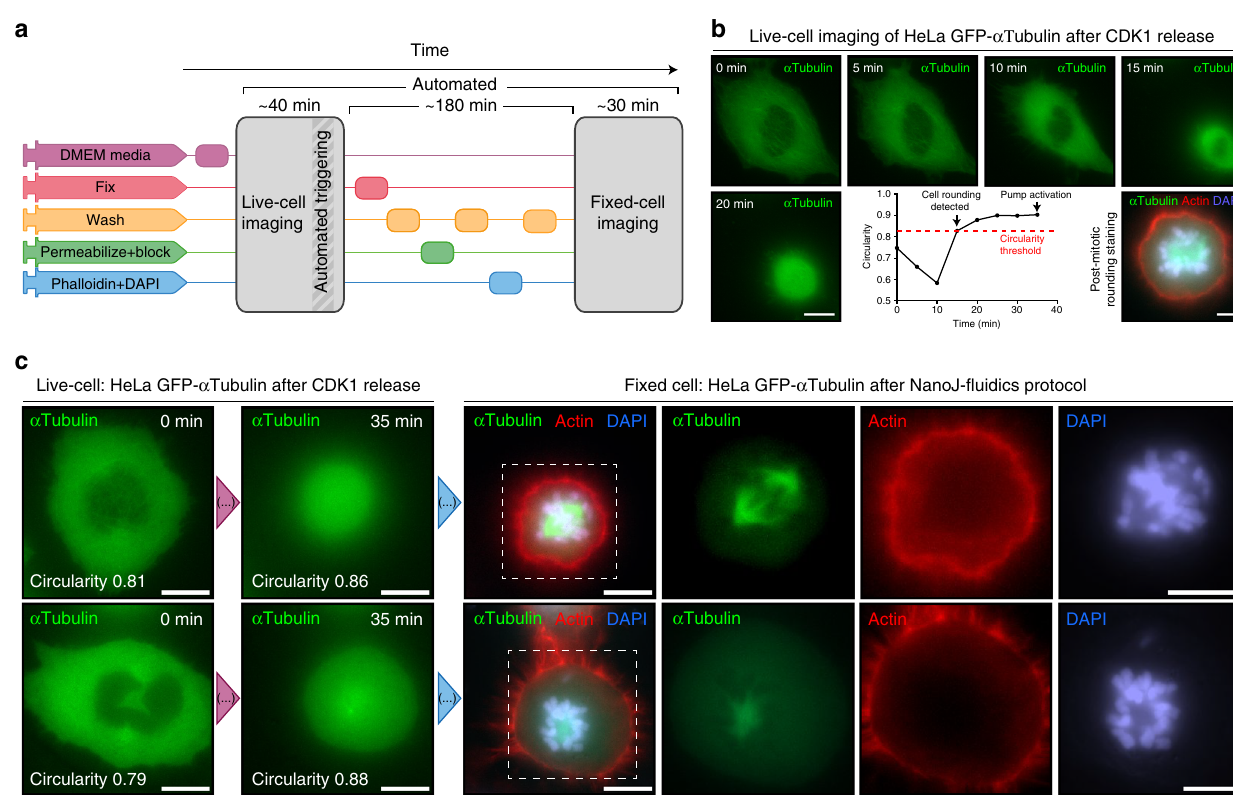
Fig. 3 Unsupervised live-to- fi xed microscopy triggered by mitotic rounding. a NanoJ-Fluidics work fl ow for the automated mitotic-rounding-driven protocol. b Stills of a HeLa cell expressing mEGFP- α -Tubulin (green) imaged live every 5 min (Supplementary Movie 2) during mitotic cell rounding, corresponding circularity analysis (graph) and overlay of the same cell after the NanoJ-Fluidics protocol (stained for actin — red, phalloidin-AF647 - and DNA — blue, DAPI). Rounding of cell shown was detected at 15 min. Pumps were activated at 35 min, 15 min after 25% of cells reached circularity threshold (Supplementary Note 5). Scale bar, 10 μ m. c Two fi elds-of-view from the same experiment as in panel ( b ) where mitotic rounding occurred and corresponding single-plane (full z-stack shown in Supplementary Movie 2) of fi xed-cell imaging of post NanoJ-Fluidics protocol, overlays and single images coloured as in panel ( b ). Scale bar, 10 μ